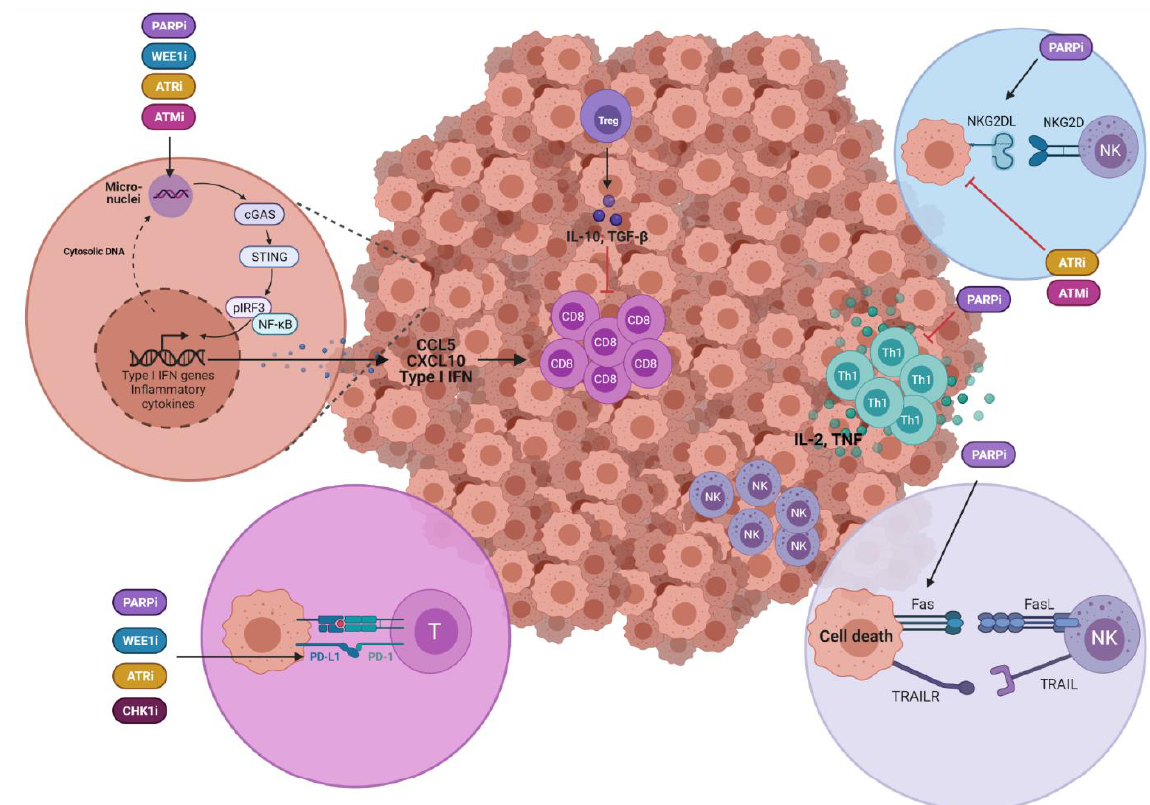
Figure 3. Schematic representation of the tumour microenvironment depicting the effects of DDR-targeted agents on the crosstalk between tumour cells and infiltrating immune cells. cGAS, GMP-AMP (cGAMP) synthase; IFN, interferon; NK, natural killer cell; NKG2DL, NKG2D ligand; PD-1, programmed death protein-1; PD-L1, programmed death ligand-1; pIRF3, phosphor IFN regulatory factor 3; STING, stimulator of IFN genes; Treg, regulatory T cells; TRAILR, TRAIL receptor.